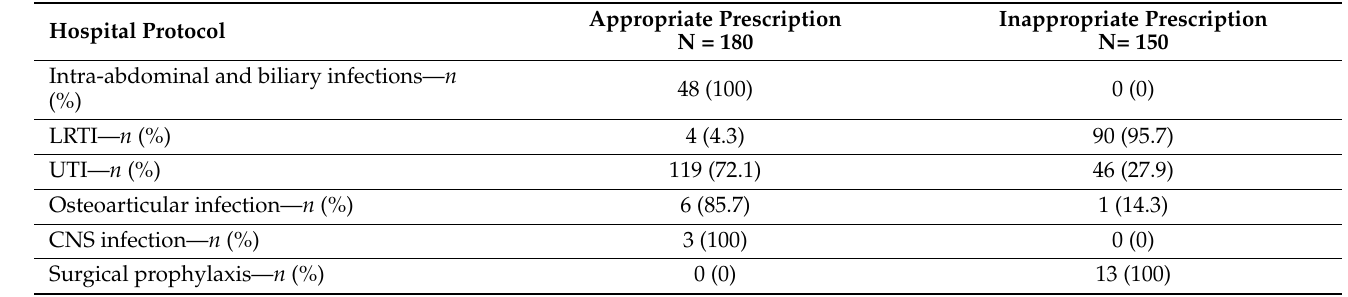
Table 3. Appropriateness of empirical ceftriaxone prescriptions for clinical conditions with a